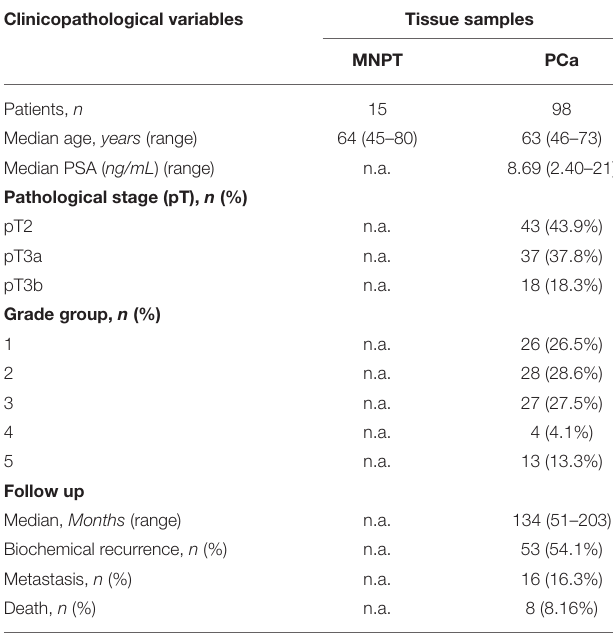
TABLE 1 | Clinical and pathological data of morphologically normal prostate and prostate cancer patients (Cohort